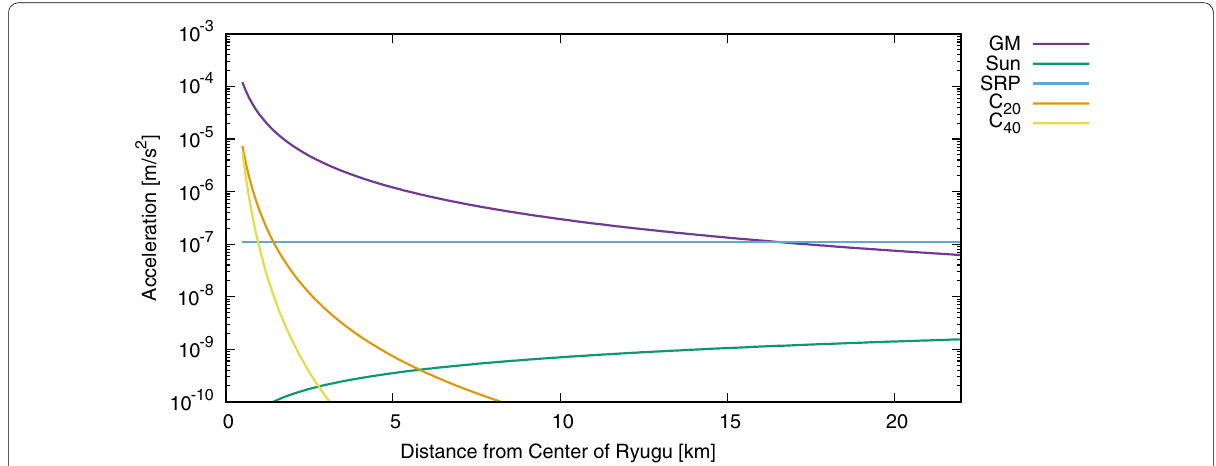
Fig. 3 Change in the magnitude of various perturbing forces affecting Hayabusa2 as a function of the distance from the center of